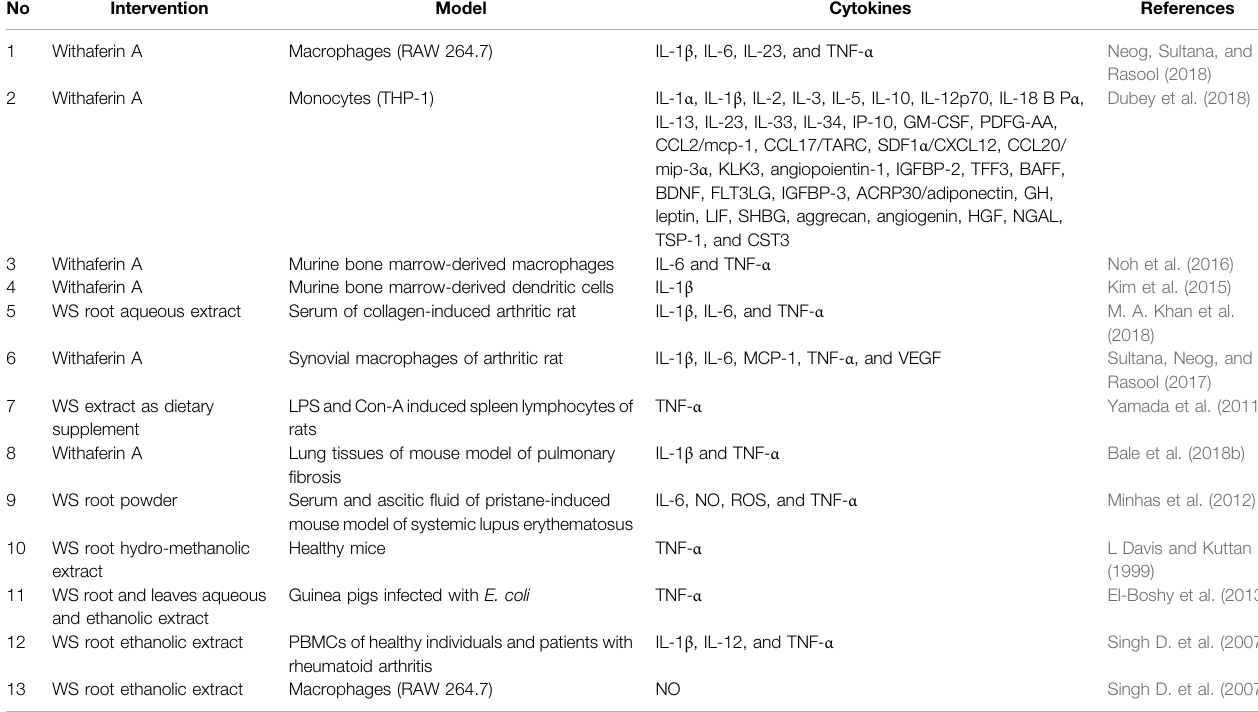
TABLE 1 | Suppression of in fl ammatory cytokines by withanolides and Withania somnifera extracts in several study models.